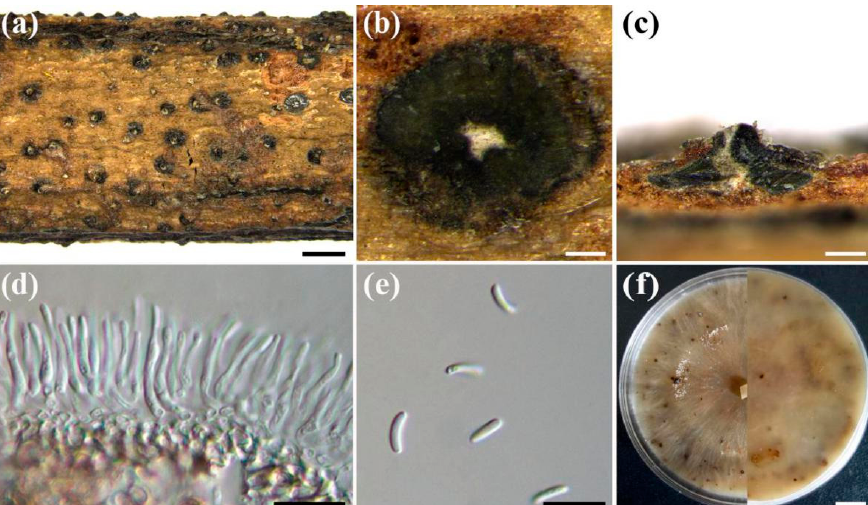
Figure 3. Cytospora haidianensis (CF 20198643). ( a ) Habitat of conidiomata on stems and branches of Euonymus alatus . ( b ) Transverse section of conidioma. ( c ) Longitudinal section through conidioma. ( d ) Conidiophores and conidiogenous cells. ( e ) Conidia. ( f ) Top (left) and bottom (right) sides of colonies on potato dextrose agar (PDA) after 30 days. Scale bars: a : 1 mm; b : 100 µm; c : 200 µm; d , e : 10 µm; f : 1 cm.